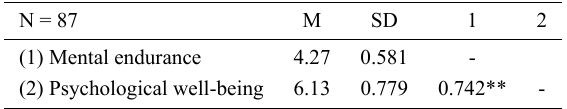
Table 2. Correlation analysis